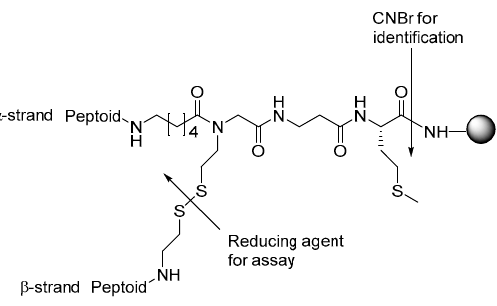
Figure 8. General structure of the Peptoid Library Agar Diffusion (PLAD) system. The identical peptoid sequences are cleaved separately: (i) with a reducing agent (e.g., a thiol) for screening of antimicrobial activity, and (ii) with CNBr to identify the active compound by mass spectrometry.